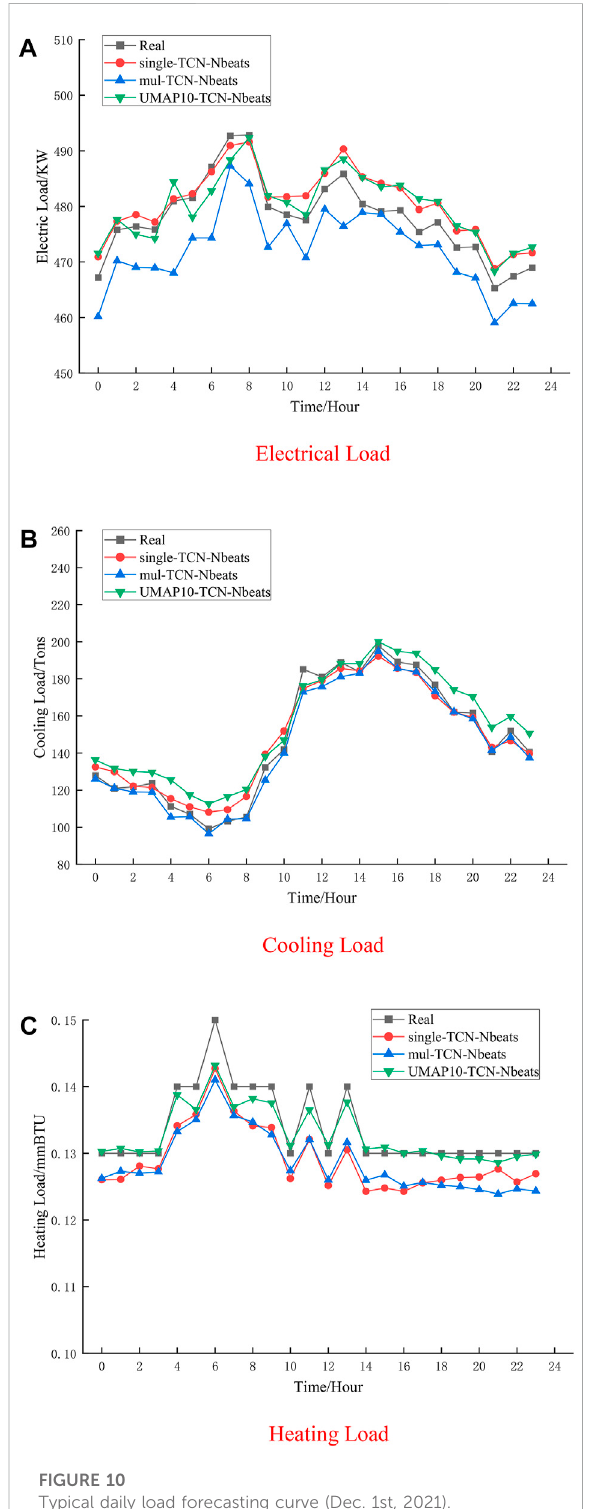
FIGURE 10 Typical daily load forecasting curve (Dec. 1st, 2021).